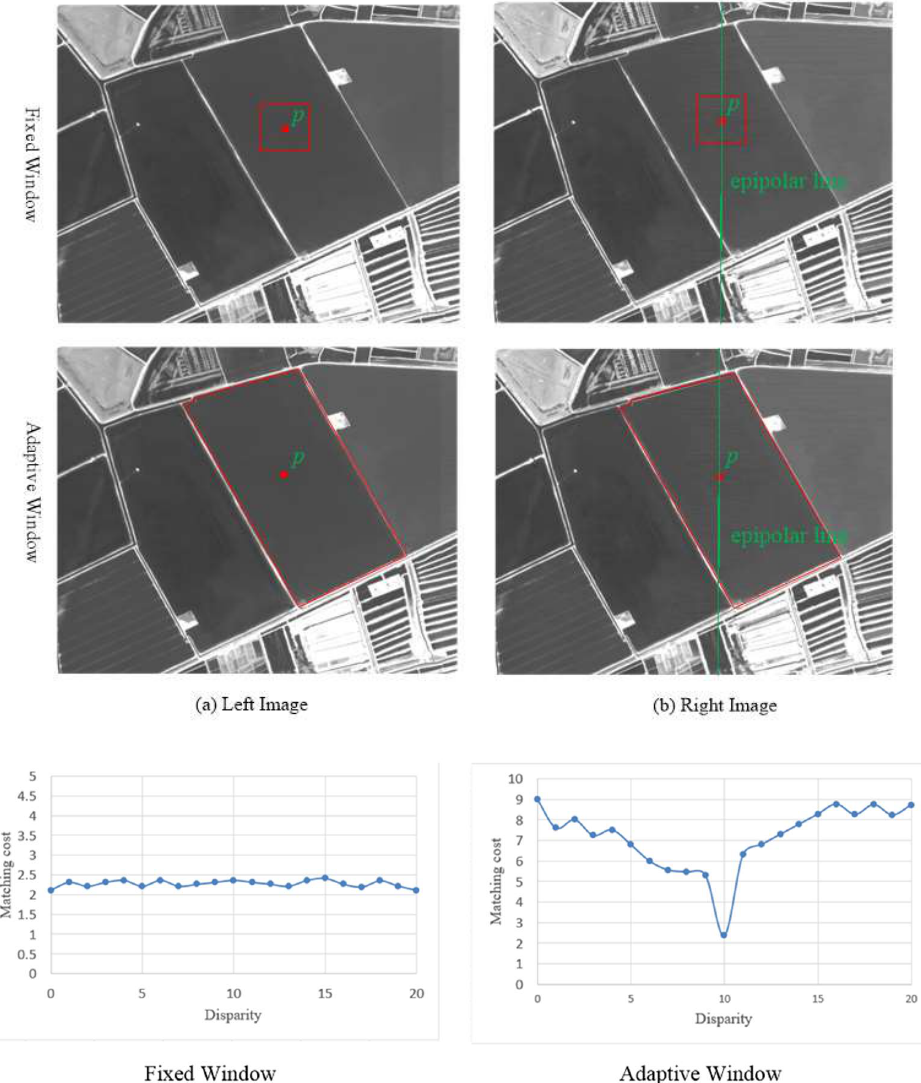
Figure 1. The comparison of “Fixed Window” and “Adaptive Window” as the matching primitive. The matching cost curves were obtained with a disparity range [0,20] along epipolar line. For the “Fixed Window”, there is no obvious minimum, while the “Adaptive Window” has an obvious minimum.